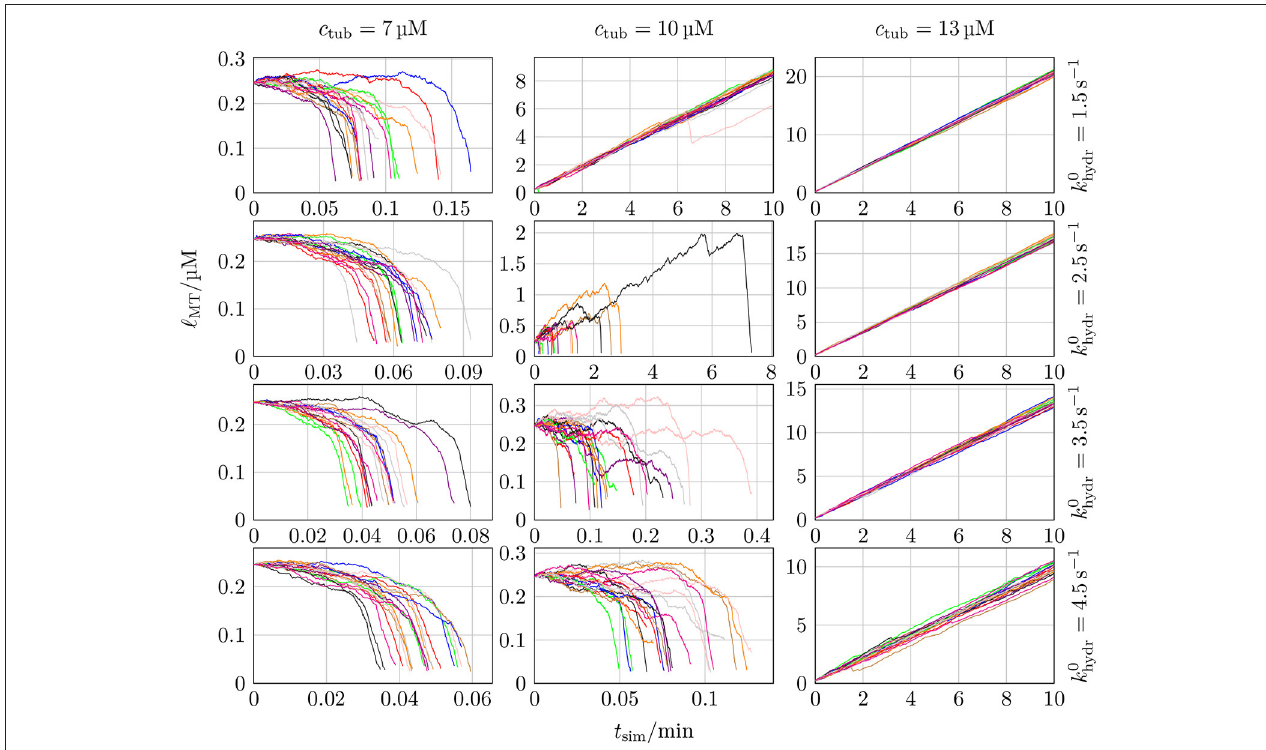
FIGURE 12 | MT length ℓ MT as a function of the simulation time t sim for 20 different simulations with k + = 4 µ M − 1 s − 1 , 1 G 0 ∗ long = − 9.3 k B T , k lat = 100 k B T / nm 2 , three different values of c tub , and four different values of k 0 hydr